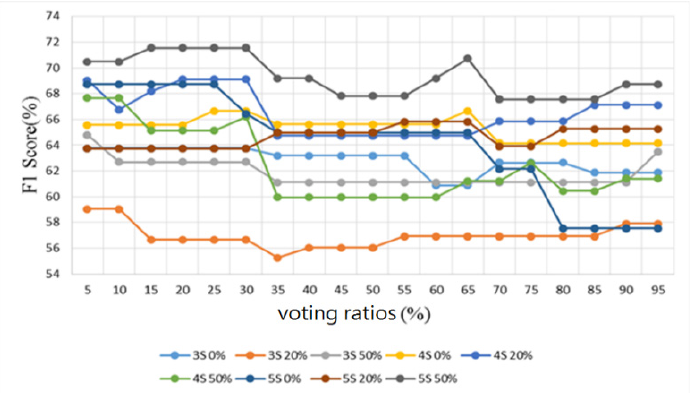
Figure 22. Lung sound classification results: Specificity.